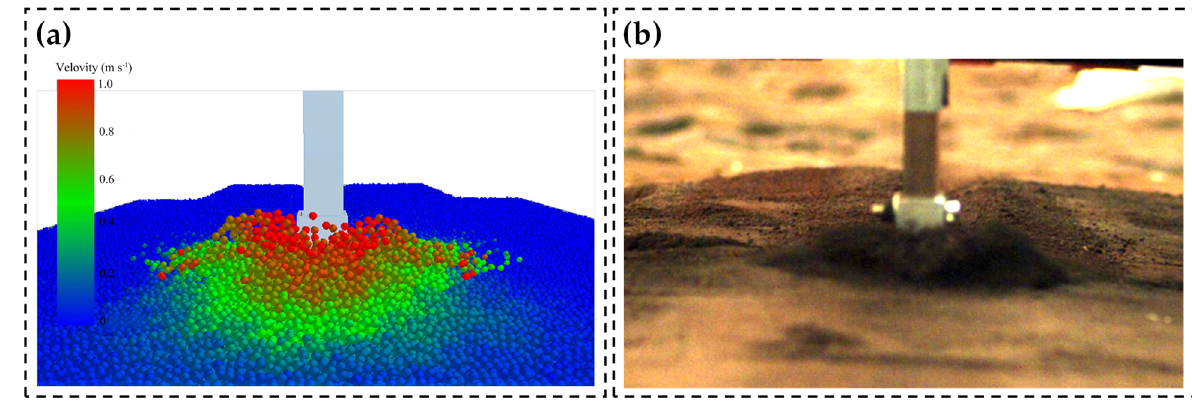
Figure 8. Comparison of results between DEM virtual simulation test and soil bin test. ( a ) Comparison of furrow contour. ( b ) Comparison of soil disturbance rate.